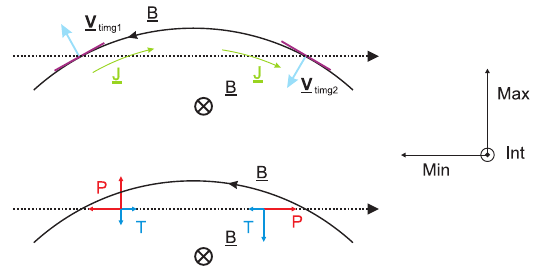
Fig. 16. Schematics of the main results of the 2 October 2003 flux rope. The magnetic field (Fig. 5), 4SCT vectors (Fig. 6) and current (Fig. 8) marked on one schematic, the magnetic pressure (red) and tension (blue, Fig. 8) marked on the other in the variance analysis frame. The relative trajectory of the spacecraft through the flux rope is marked by a dotted